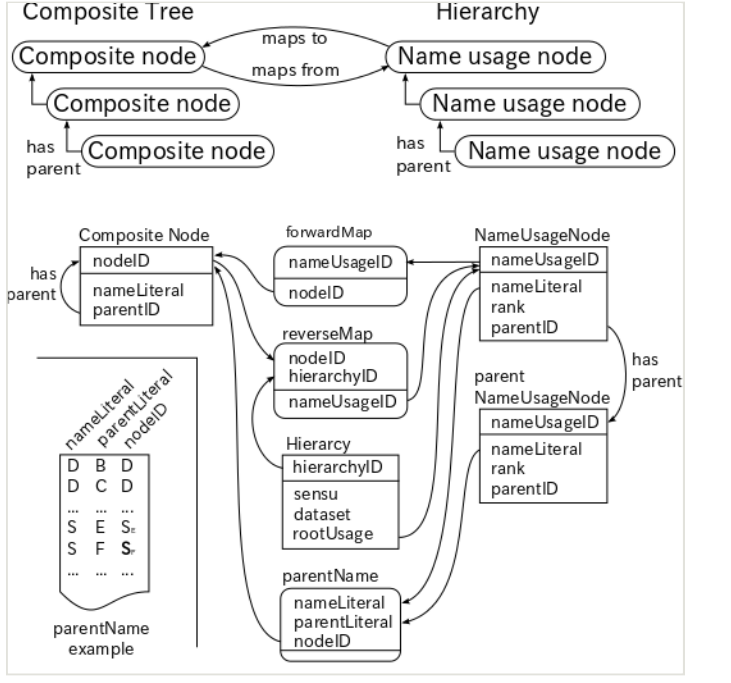
Schematic diagram of the data structure for the composite tree. In addition to the fundamental TreeModel data the composite tree possesses three mapping tables. First the forward map, which links each name usage node to a composite node. Second the reverse map, which links the composite node to each name usage node in the hierarchies under comparison. It can link a single composite node to multiple name usage nodes. Third the parental name, which links pair of the name literal and its parental name literal of a name usage node to the composite node. It providers a working cache of candidate composite nodes to which the name usage literal and parental name literal of the name usage node in the hierarchy being processed,